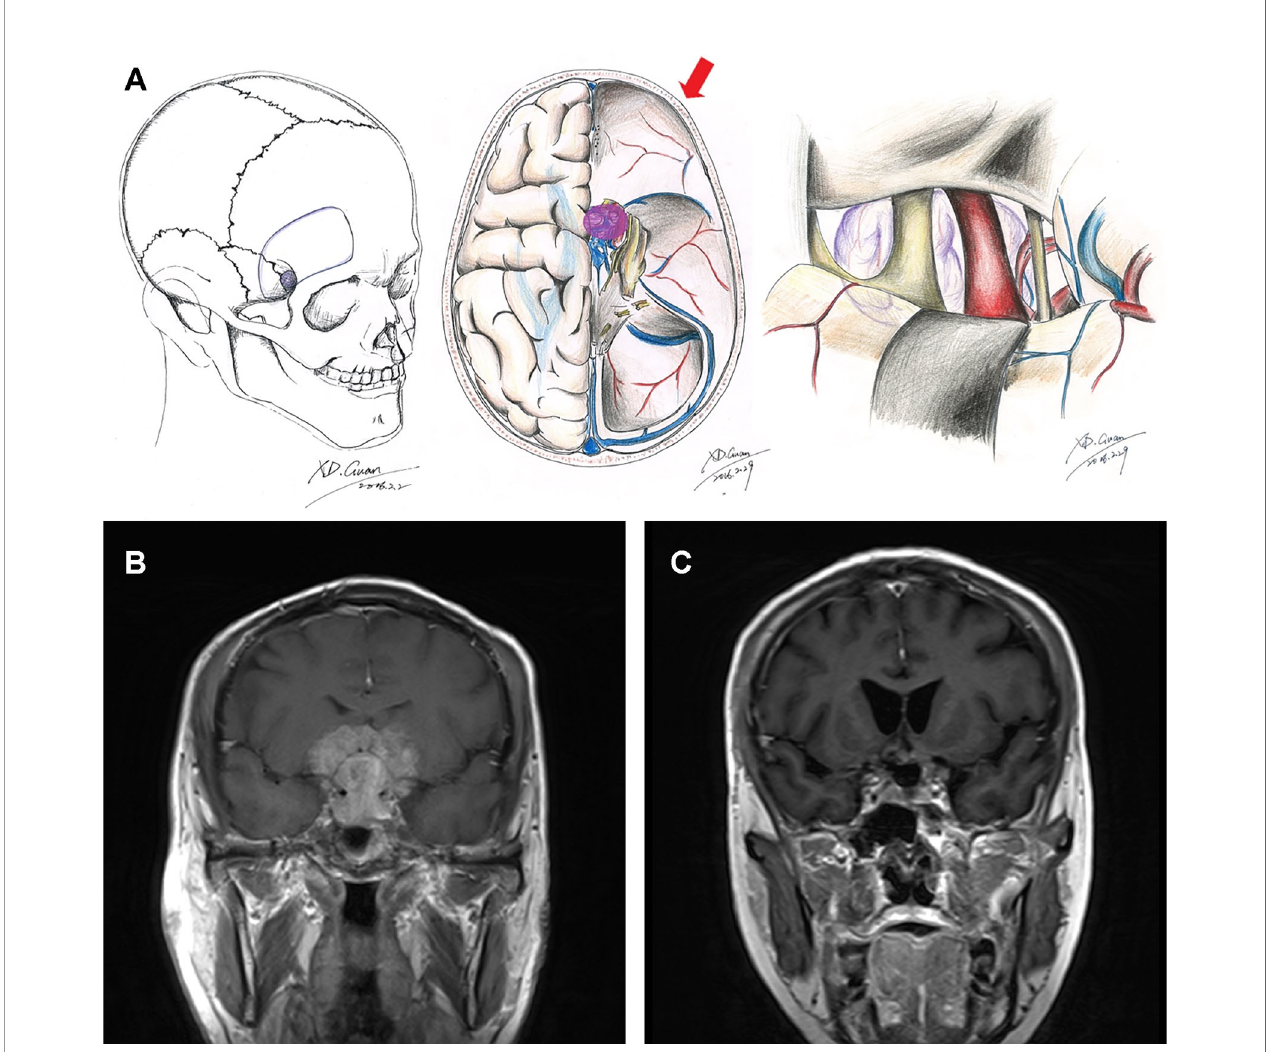
FIGURE 1 | Schematic diagrams and MRI images of frontolateral approach. Schematic diagrams of incision, surgical fi eld, and microanatomy of frontolateral approach (A) . Preoperative (B) and 3-month postoperative (C) coronal enhanced MRI images of a giant pituitary adenoma in Knosp grade 4 that underwent the frontolateral